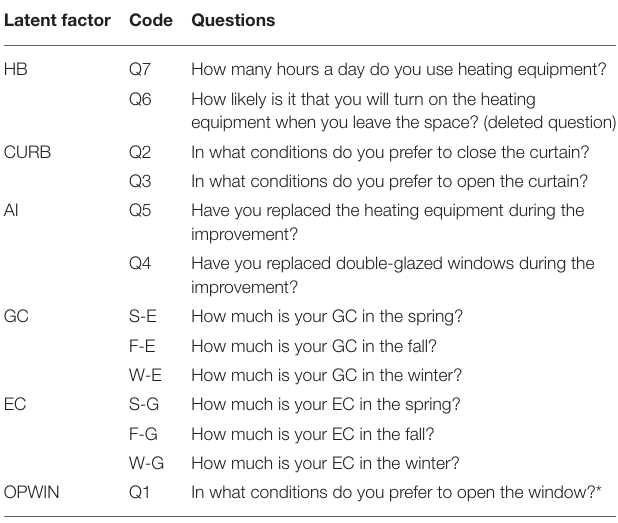
TABLE 4 | The hypotheses of the study. (HB) affects on (GC) and (EC) significantly (OPWIN) affects on (EC) and (GC) significantly (AI) affects on (EC) and (GC) significantly (CURB) affects on (EC) significantly